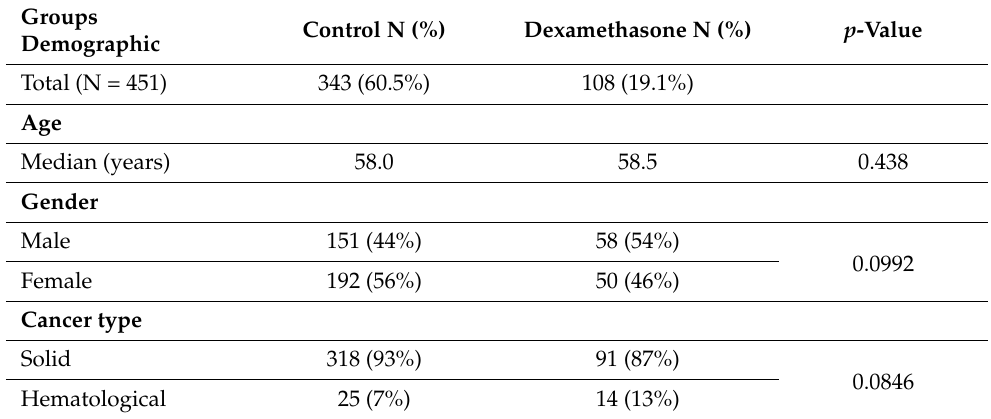
Table 1. Demographics of the study population showing no significant differences in the characteris- tics of both